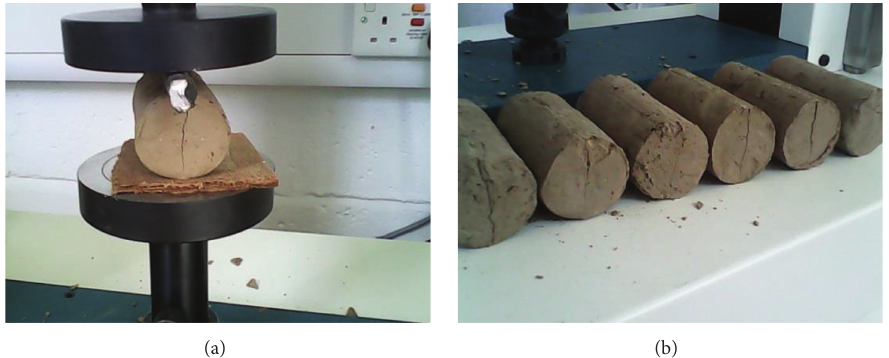
Figure 5: (a) Specimen under tensile stress, (b) failed specimen.